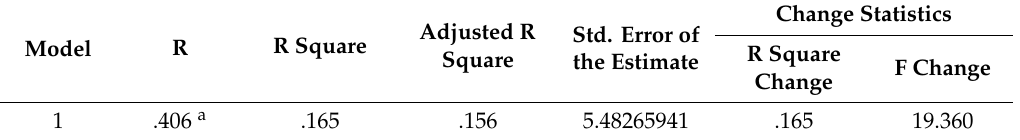
Table 13. Model summary between SEO performance and website quality.